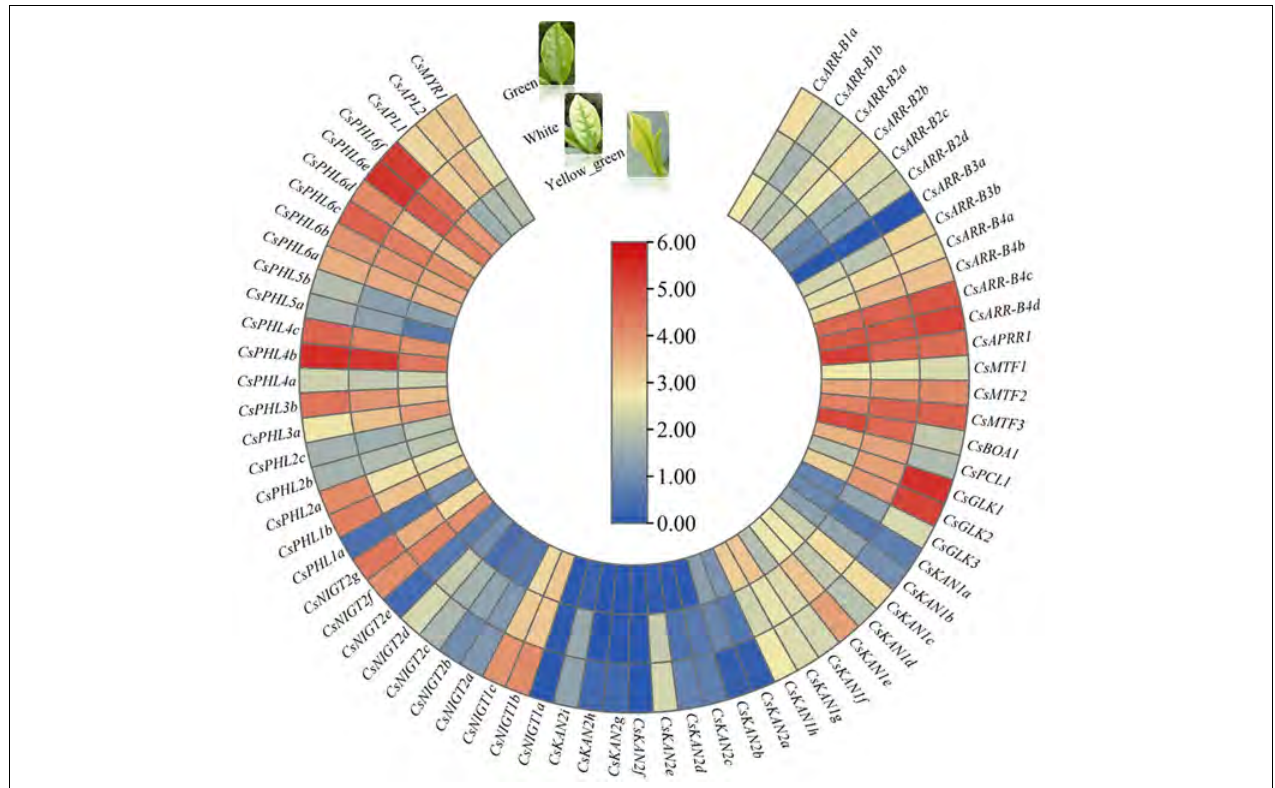
FIGURE 9 | Expression analysis of CsGARPs in different tea plant leaf color stages. The expression levels of CsGARPs were calculated with TPM values. The red and blue colors represent high and low expression levels,